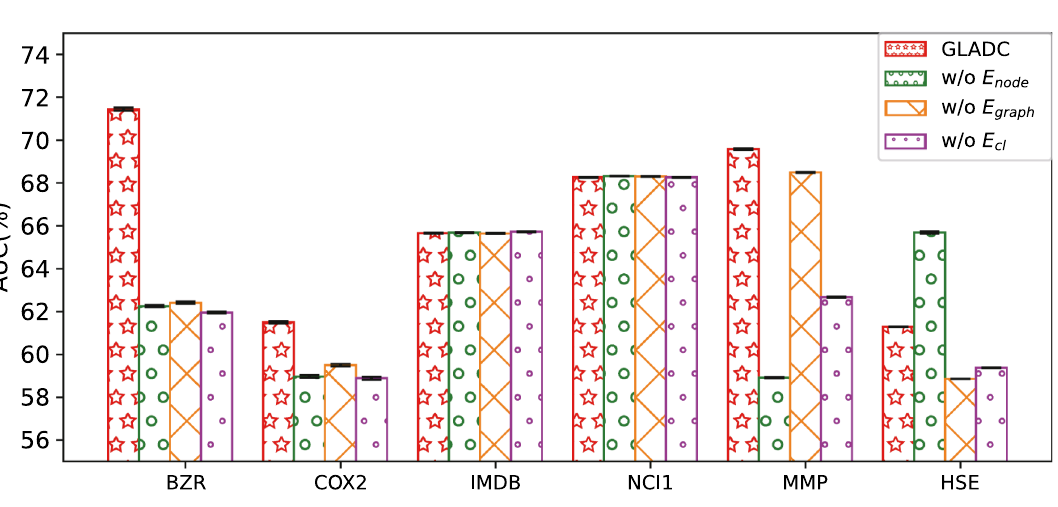
Figure 4. Ablation analysis for GLADC model on six